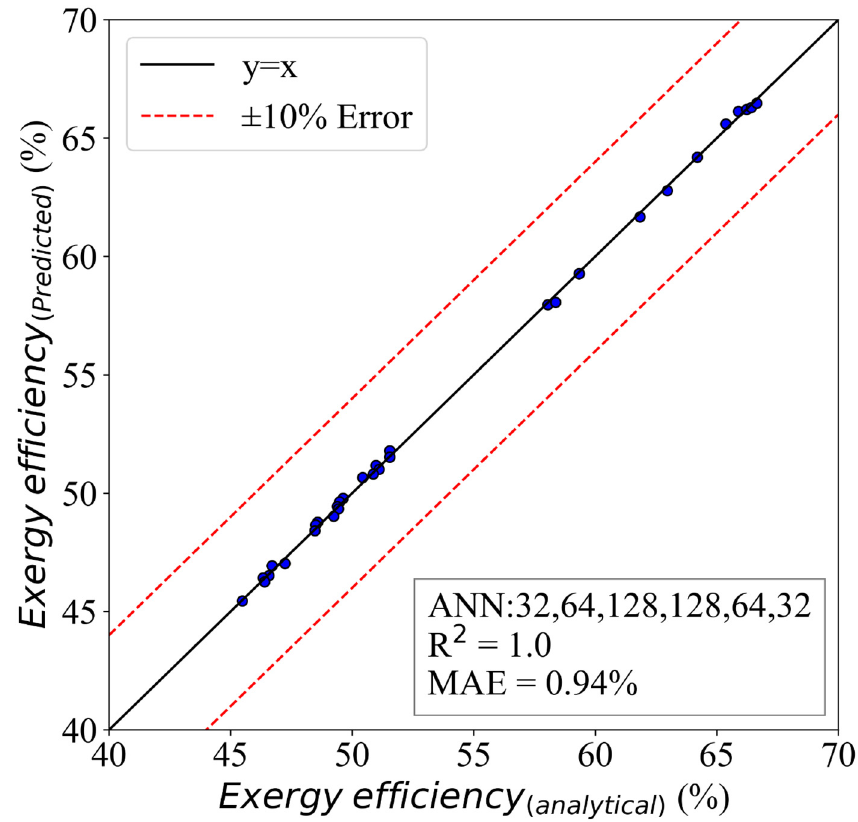
Figure 13. The ANN model of exergy efficiency with an HL structure of (32,64,128,128,64,32).